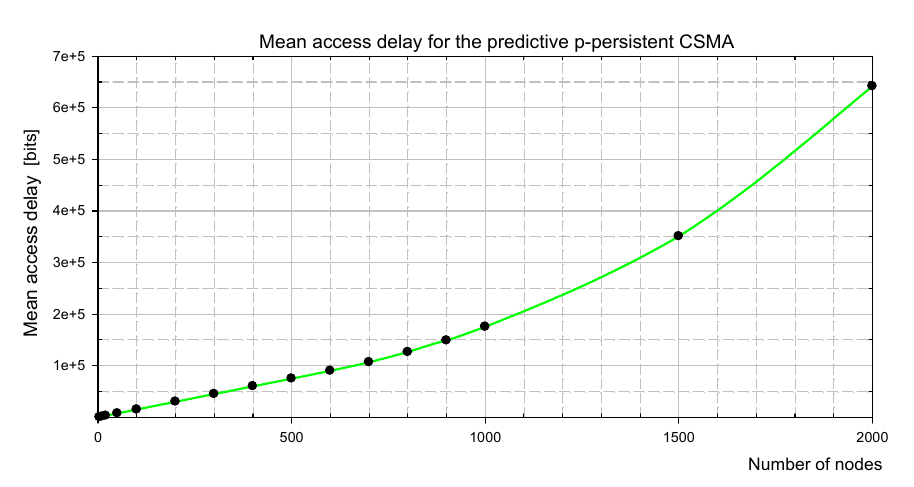
Figure 8. Mean access delay versus the number of nodes for the predictive p -persistent